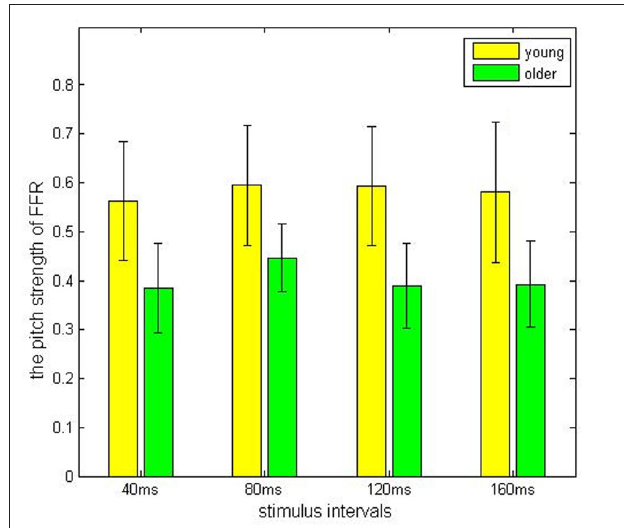
FIGURE 3 | The stimulus-to-response correlation coefficients obtained from the young (yellow) and the elderly (green) groups, grouped by different ISIs.